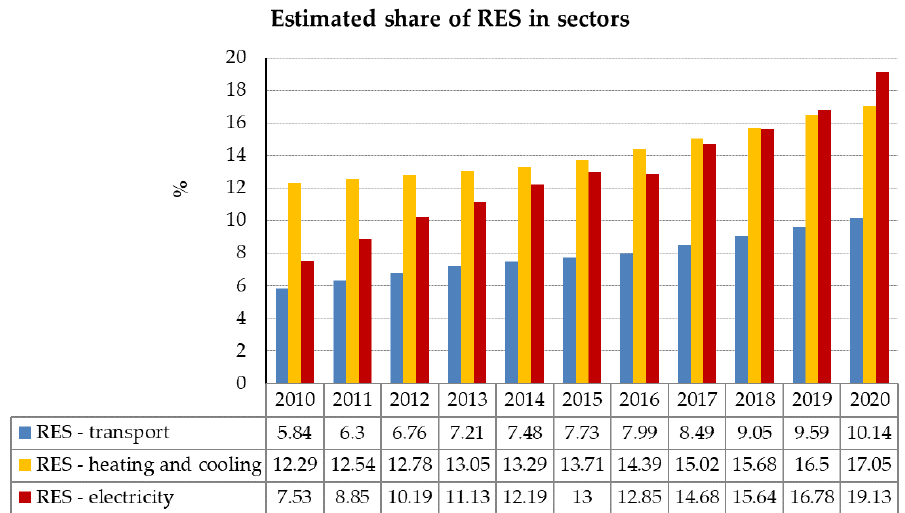
Figure 3. Share of renewable energy generation in different sectors according to the National Renewable Energy Action Plan [30].